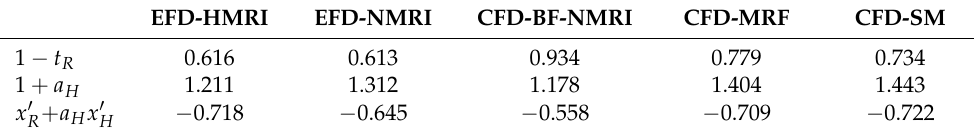
Table 8. The hull-rudder interaction coefficients obtained from the rudder force